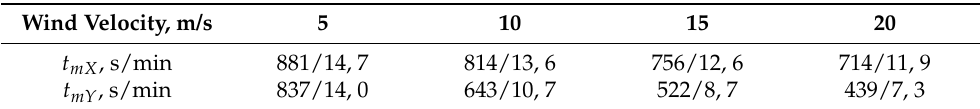
Table 5. Possible maneuvering time within channel bend depending on wind velocity ( X im = 250 m; Y im = 180 m).